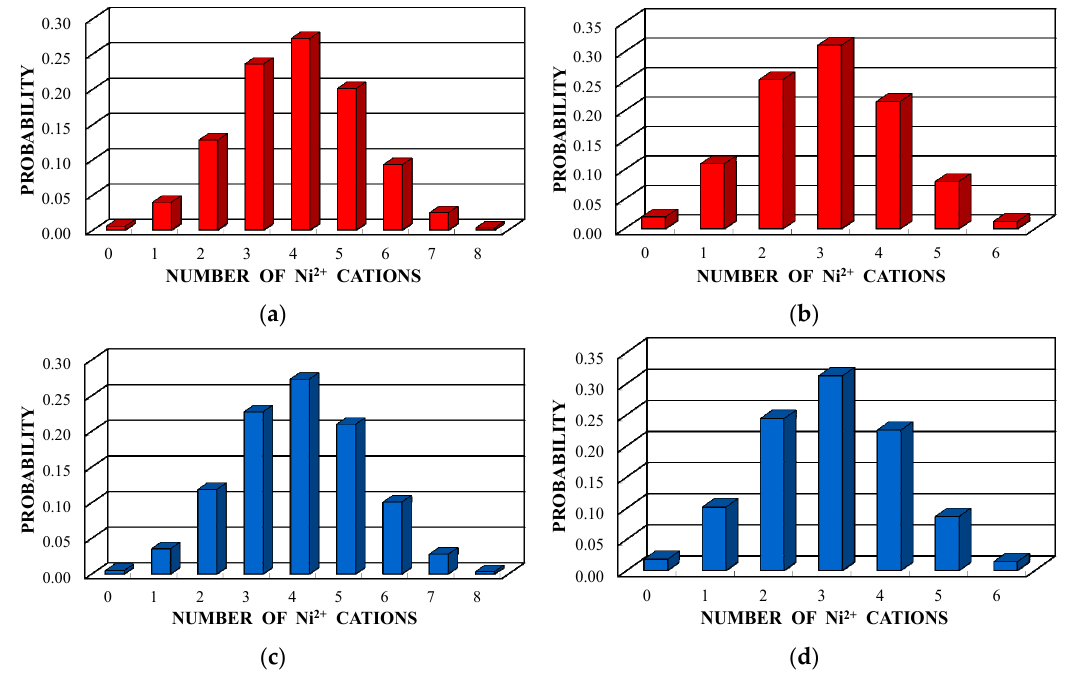
Figure 51. Histograms of the probabilities of different numbers of Ni 2+ cations in the local micro ‐ environments of Fe 3+A ( a , c ) and Fe 3+B ( b , d ) cations within the coordination sphere of 3.5 Å in the ideal NiFe 2 O 4 crystal with chemical compositions corresponding to NA ( a , b ) and NB ( c , d ) samples. Adapted from Ref. [79] with permission from Elsevier: Materials Chemistry and Physics, Vol. 202,